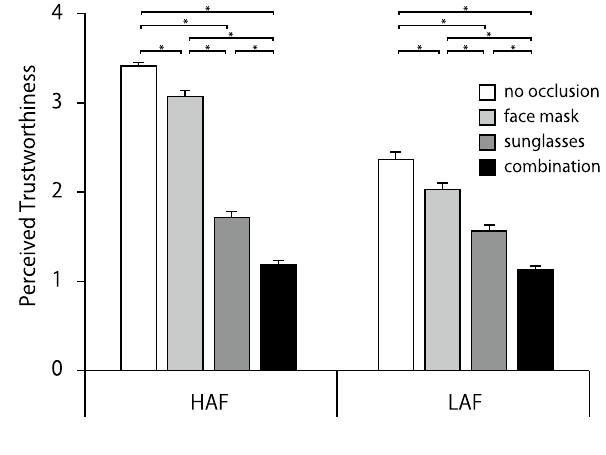
Fig. 4 Mean trustworthiness ratings for each condition. Error bars represent standard errors. As the time effect was not significant, data were averaged across time point. Lines with * indicate that Bonferroni-corrected pairwise comparisons between condi- tions were significant, p <